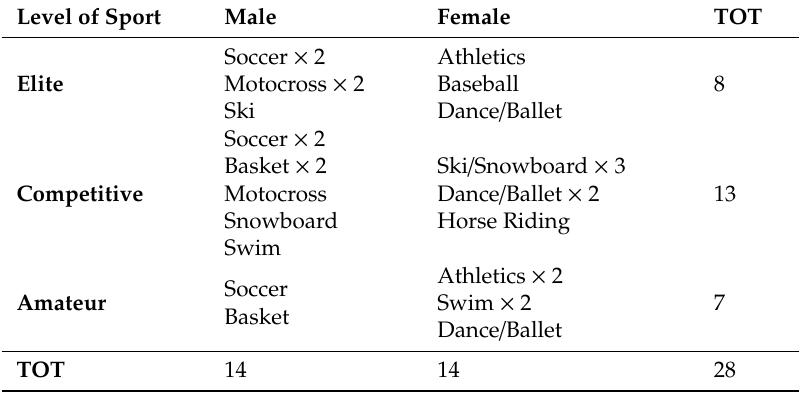
Table 4. Type and level of sport of patients after TSA